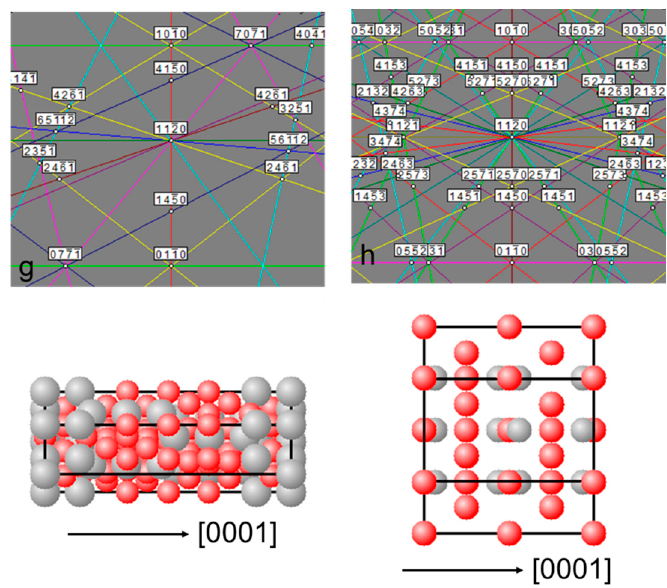
Figure 1. Computer-generated EBSD patterns for the (11 2(cid:3364) 0) planes of ( a ) LaNi 5 ; ( b ) Pr 5 Co 19 ; ( c ) Nd 5 Co 19 ; ( d ) Ce 2 Ni 7 ; ( e ) Pr 2 Ni 7 ; ( f ) CeNi 3 ; ( g ) PrNi 3 ; and ( h ) NbCr 2 (hexagonal). SEM-backscattered electron image (BEI) of the 8-h annealed sample is shown in Figure 2, and several spots were studied in detail (spots Z1 to Z6, A to C, and Y1 to Y13). For spots Z1 to Z6, their original EBSD patterns, fitted patterns, and simulations of grain orientation are shown in Figure 3. Other than the base structure (LaNi 5 , spot Z1), both the A 2 B 7 (spots Z2 and Z3) and AB 3 (spot Z4) superlattice structures, Mg metal (spot Z5), and AB 2 (spot Z6) phases are found as the new phases.